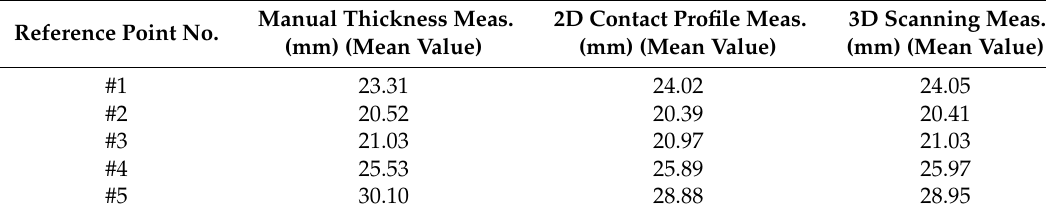
Table 1. Comparison of Results in Test 1.